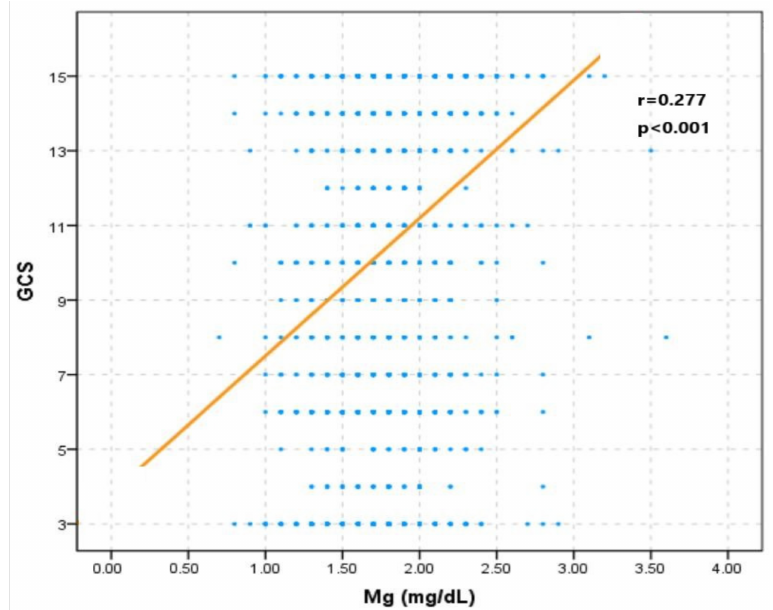
Figure 6. Correlation between GCS and serum magnesium